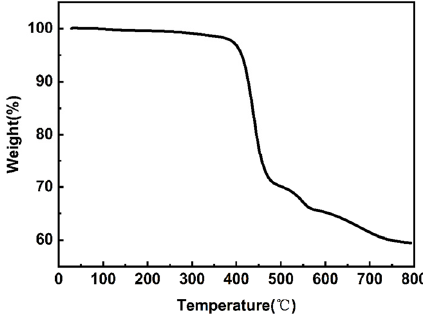
Figure 3. TGA curve of PF-BBO.